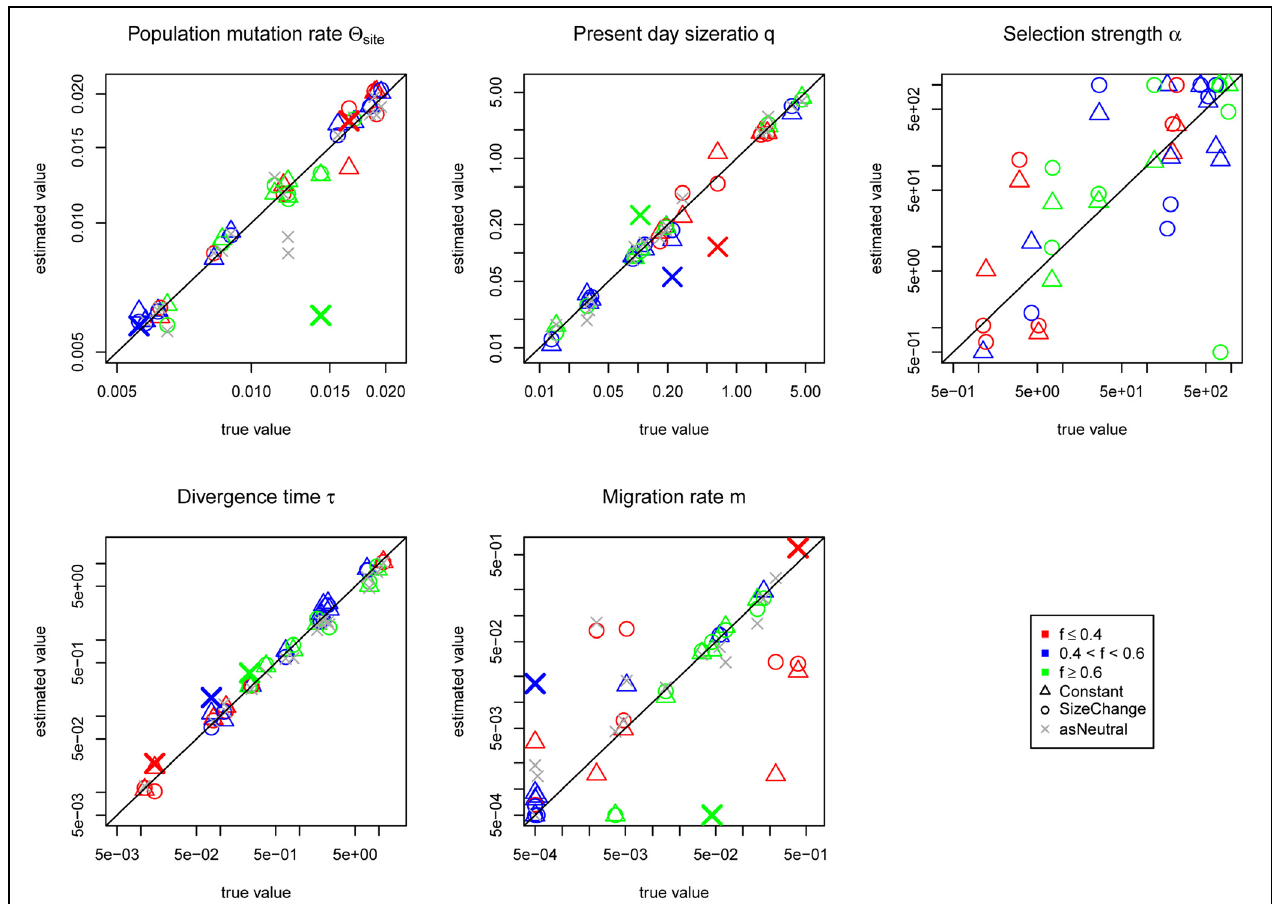
FIGURE 3 | Jaatha results of the simulation study under the incomplete sweep scenario for the Constant ( (cid:2) ) and the SizeChange ( o ) model. For the SizeChange model neutral estimates are also given (x, as Neutral). The average frequency of the selected allele f in the data set is colored accordingly. To distinguish which estimates came from the same data set, three neutral estimates are color-coded and increased in size and show the covariance of the present day population size q with the migration rate m . These three colored ’X’s represent the neutral estimate for the corresponding colored SizeChange ( o )